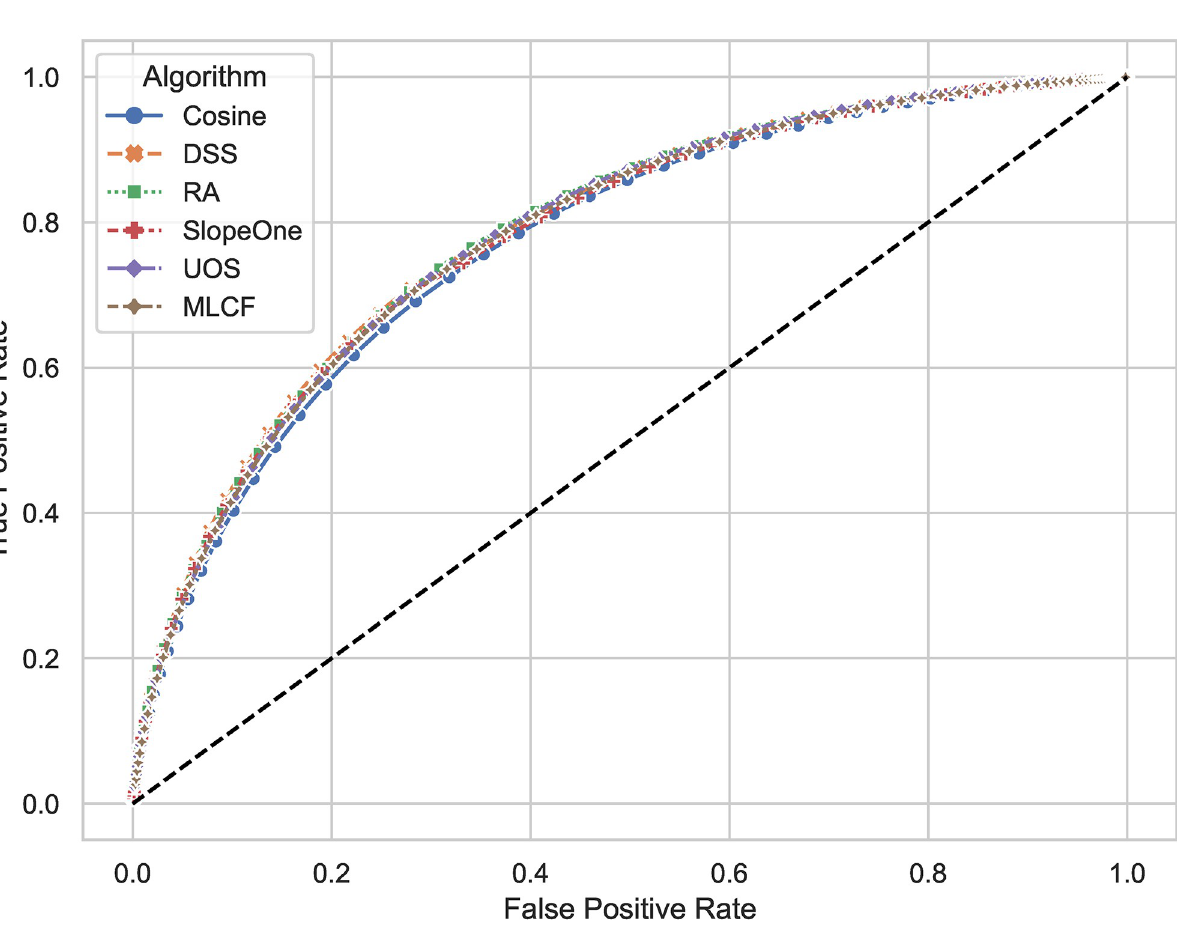
Fig 8. Comparison of receiver operating characteristic curve ( ROC ). The area under curve ( AUC ) of DSS is the largest between false positive rate 0.0 and 0.3, the third between 0.3 and 0.8375, and the second between 0.8375 and 1.0, but the advantage of leading algorithms at all stages is very small. For example, DSS has a 1.67 percent advantage over RA at FPR = 0.19 (false positive rate).